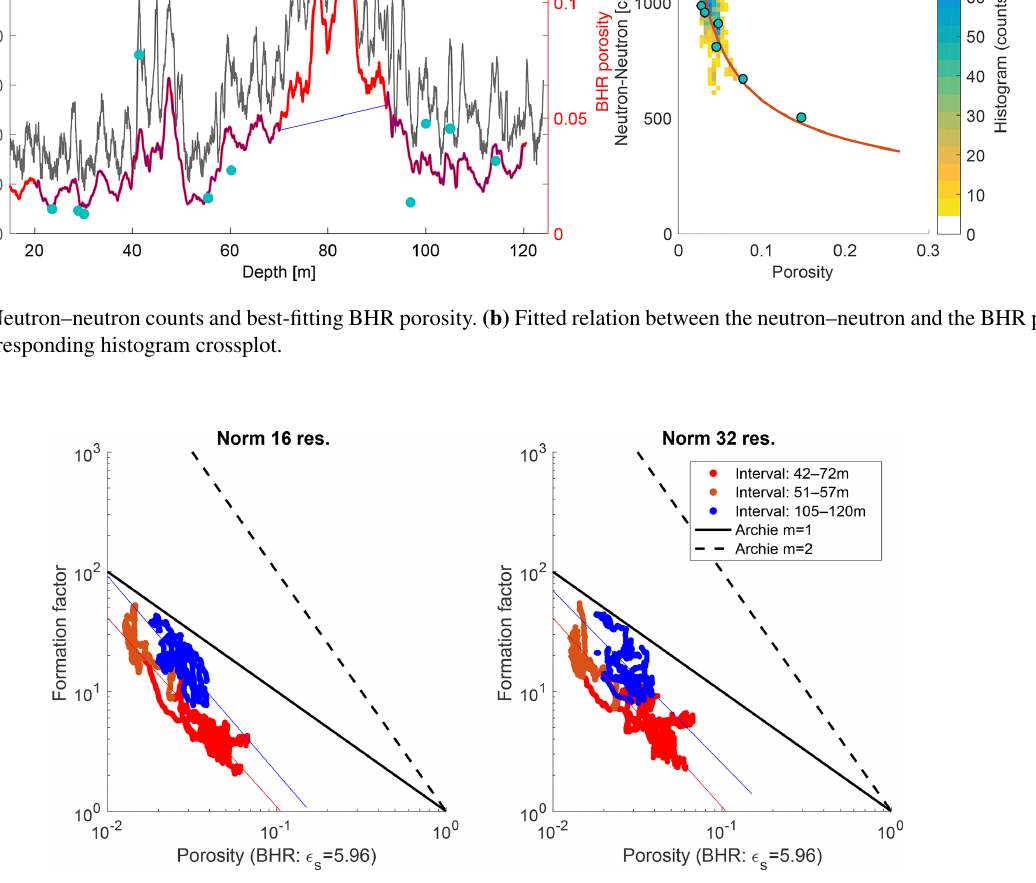
Figure A4. Formation factor vs. porosity obtained from the borehole radar for a permittivity of the solid of 5.69. The formation factor is calculated from the normal resistivity measurements of 16in. (0.4m) and 32in. (0.8m) (2016) and the fluid resistivity obtained from the STS measurement at ambient conditions (2016). For comparison Archie’s law with a cementation factor of m = 1 and m = 2 is